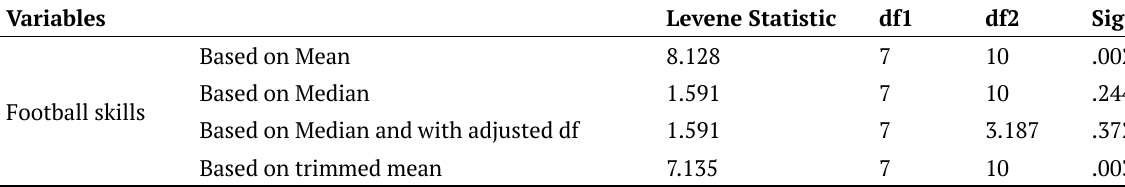
Table 6. The Endurance towards the Football Skills Variables